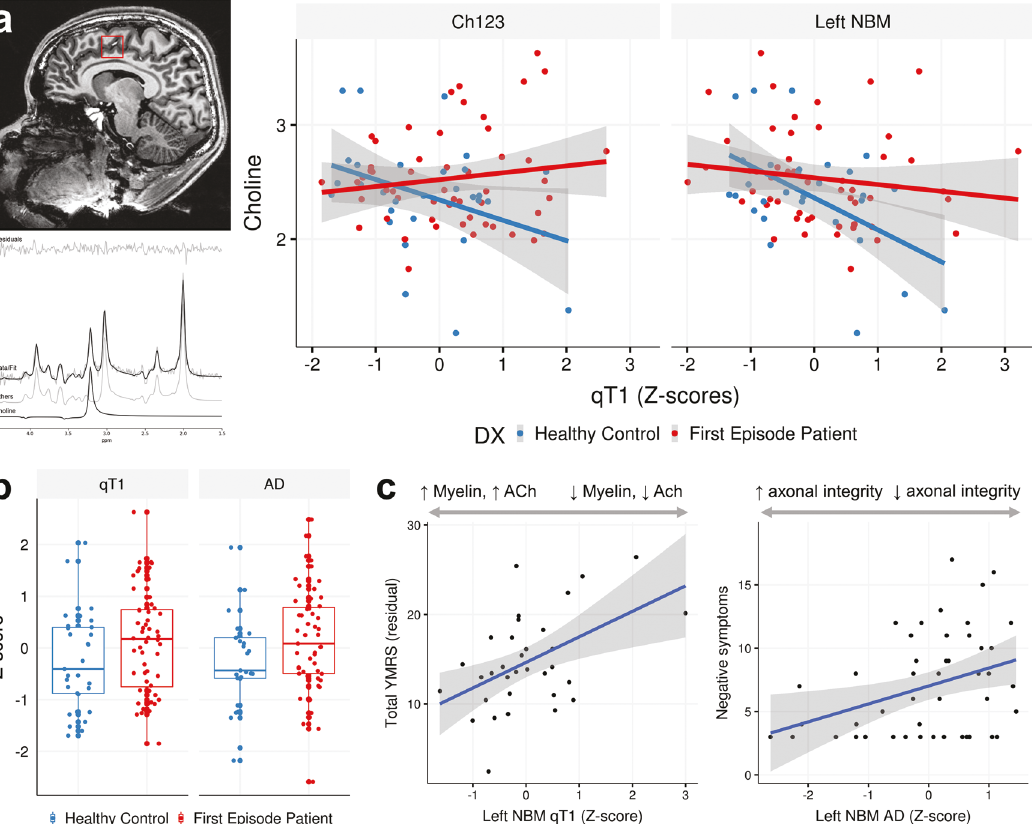
Fig. 1 Evidence for microstructural changes of the basal forebrain in FEP. a Left: Magnetic resonance spectroscopy of choline in the dACC with example of voxel placement (top), and spectral fi t for choline (bottom). Right: In FEP, there is decoupling of the correlation between qT1 and choline levels, while a signi fi cant correlation exists in healthy controls such that lower qT1 (higher myelin) is associated with elevated choline levels. b In the Ch1-3, there is increased qT1 (lower myelin), and increased axial diffusivity. c Higher qT1 (indicating lower myelin) of the left NBM is associated with greater manic symptom severity, and increased AxD (re fl ecting lower axonal integrity) is associated with negative symptom severity. Left: y -axis shows residuals of the linear regression (YMRS ~ cannabis use) added to the mean YMRS score.